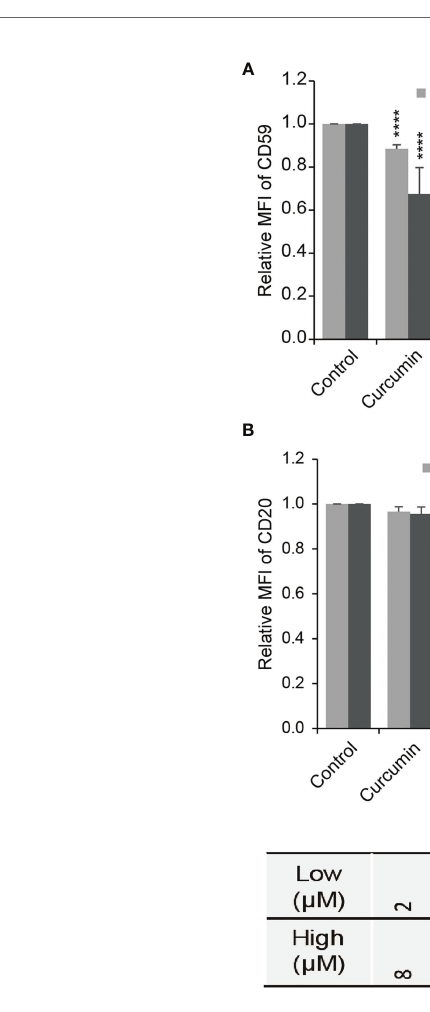
FIGURE 3 | The effect of NF- k B or CBP/p300 inhibitor on the expression of CD59 and CD20. (A, B) The effects of NF- k B inhibitors (excluding C646) and CBP/ p300 inhibitor C646 on CD59 (A) and CD20 (B) expression determined by FACS in LY8 cells. Gray bar: low concentration; Black bar: high concentration as indicated in Supplementary Figure 2 . The values represent mean ± SD, n = 3. * P < 0.05, ** P < 0.01, *** P < 0.001, **** P < 0.0001 vs.